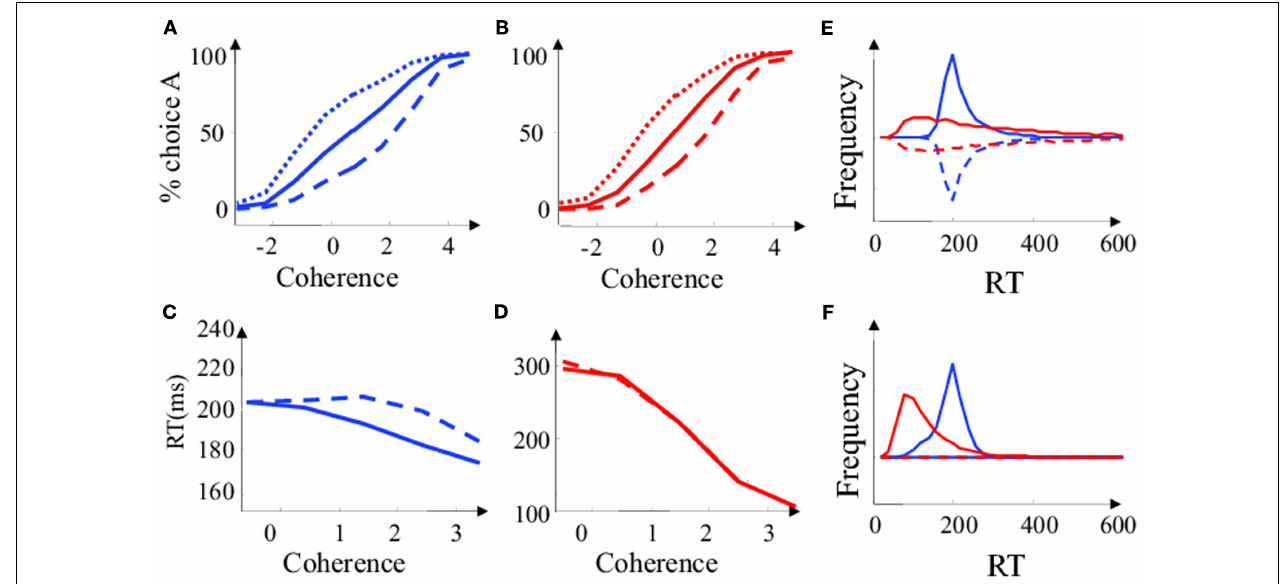
FIGURE 4 | Simplified Bayesian and “diffusion” decision model in the “reaction time” task. (A) Proportion of choice A as a function of motion coherence for the simplified Bayesian model. Positive coherence corresponds to stimuli moving in direction (A) , negative coherence to stimuli moving in the opposite direction. Plain Lines: the two choices are a priori equiprobable ( L o = 0). Dashed line: (B) is a priori more probable than A ( L o =− 0.6). Dotted line: (A) is a priori more probable than B ( L o = 0.6). (B) Same as is (A) , for the diffusion model. (C) Mean reaction